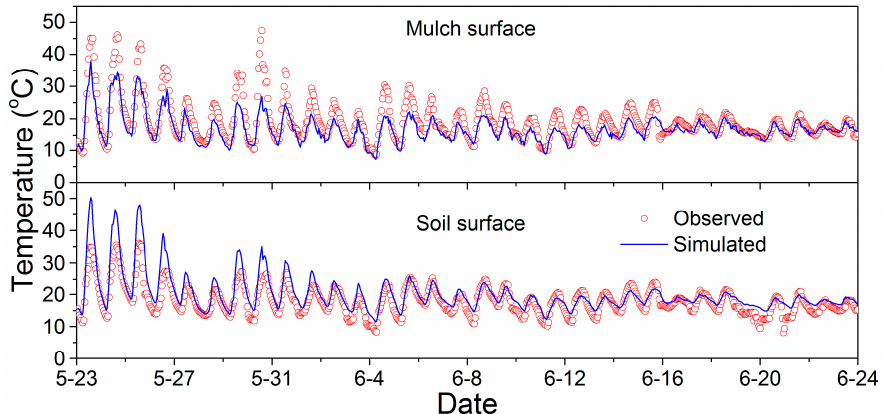
Figure 7. Comparison of the observed and simulated hourly temperatures on the transparent plastic film mulch (TM) surface and soil surface at Wuwei, China, in 2015. Agronomy 2020 , 10 , 190